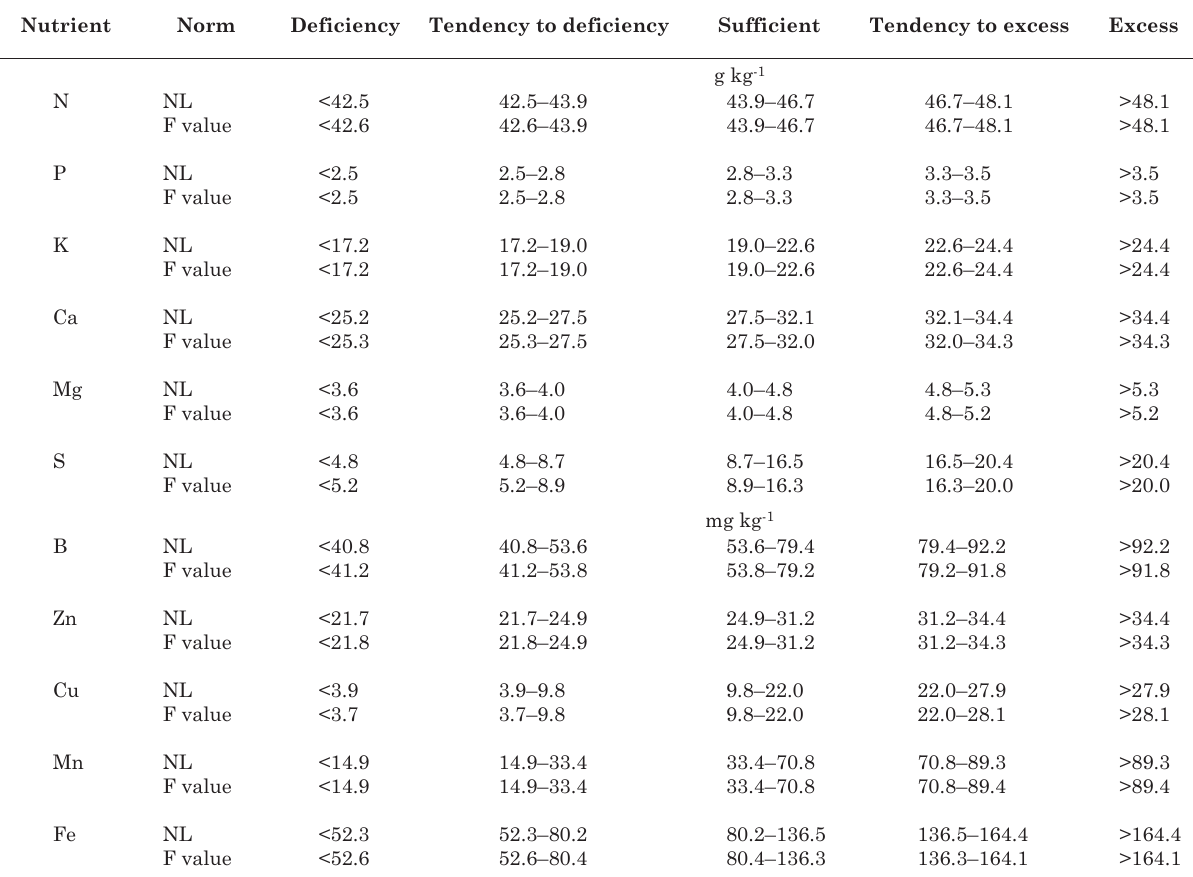
table 3. Beaufils ranges determined for the nutritional diagnosis of cotton plants based on DRis norms (nl transformation and f value)